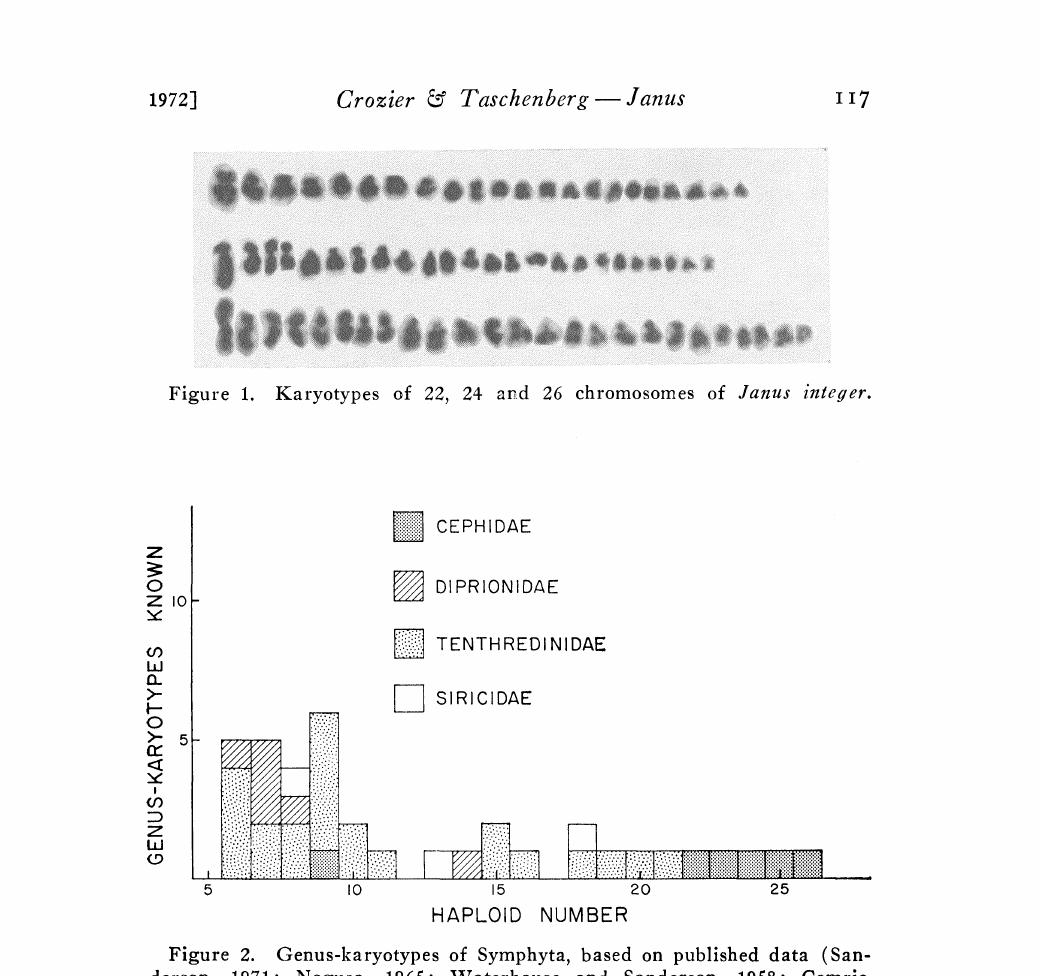
Figure 2. Genus-karyotypes of Symphyta, based on published data (San- derson, 1971; Nogusa, 1965; Waterhouse and Sanderson, 1958; Comrie, 1938; Maxwell, 1958; Mackay, 1955). Benson’s (1950) review does not give sources for the counts given, and Sanderson’s (1932) counts were later shown by her (Sanderson, 1971) to be in error; counts from before these two and pre-1932 sources have therefore been